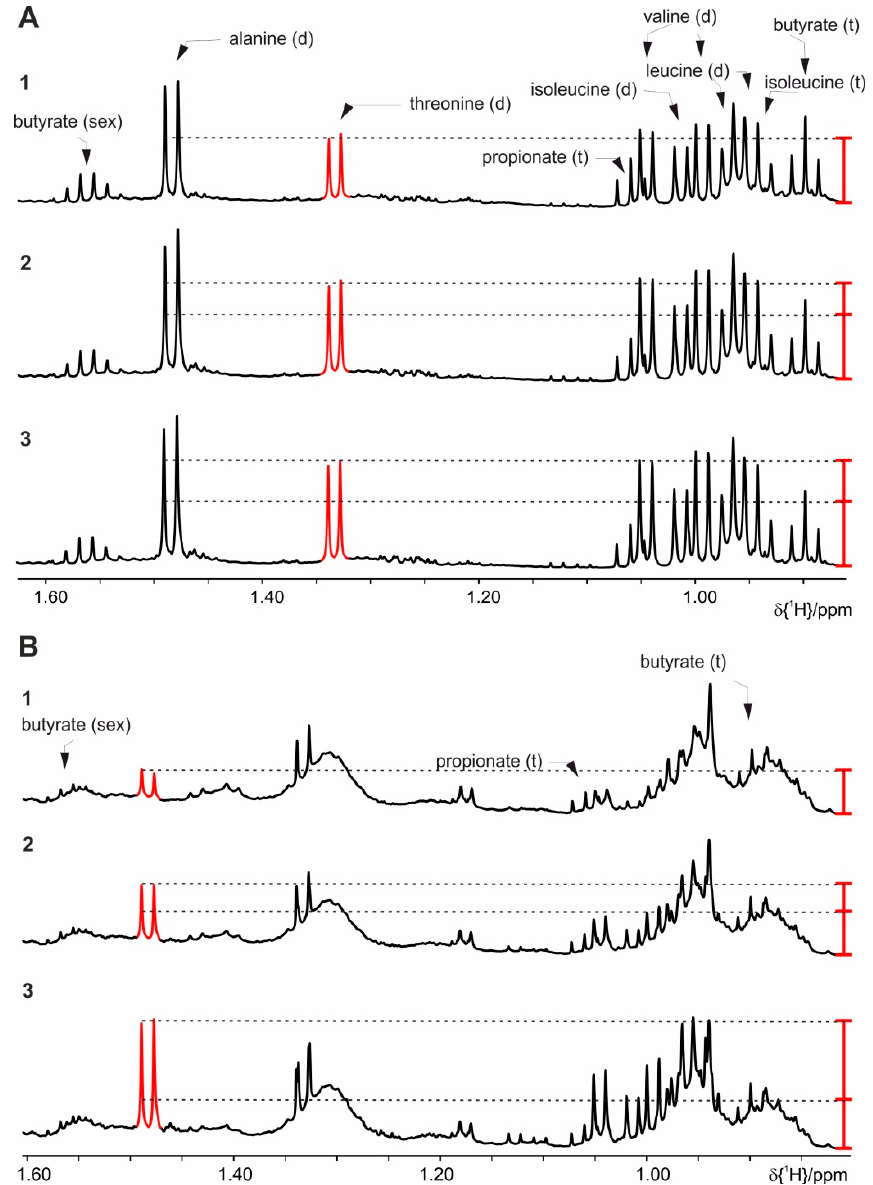
Figure 1. Proton nuclear magnetic resonance (NMR) spectra, which demonstrate changes in some of the metabolites extracted with phosphate buffer with extended storage at RT: ( A ) Mice fed on standard diet, ( B ) on high fat diet (HFD). 1 sample kept at 4 °C before measurement, 2 after 6 h, and 3 after 24 h in the sample changer at RT. For clarity only the spectral region of interest, harboring resonances of the short chain fatty acid (SCFA), is shown. The red bar indicates the increased signal intensities. Sample stability at room temperature is another critical issue as: (a) single mice feces sample can (b) samples are measured in an automated mode using a sample changer, which often is not